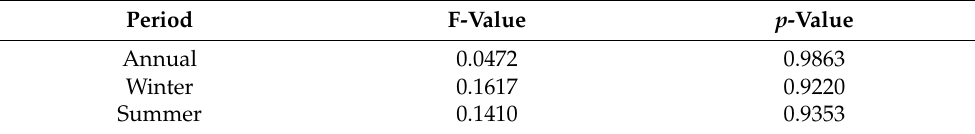
Table 8. Summary of the output ANOVA and Tukey–Kramer tests for future extreme Tm .